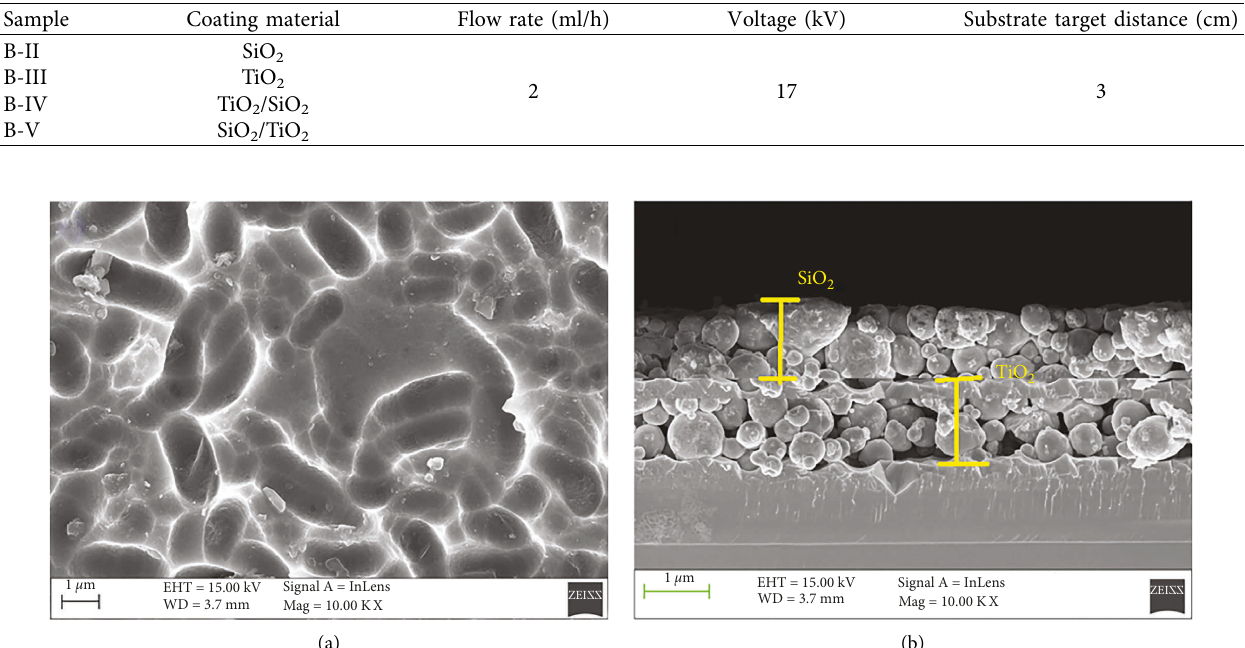
Figure 1: Pictorial representation of electrospraying Table 1: Sample description and maintained coating parameters.